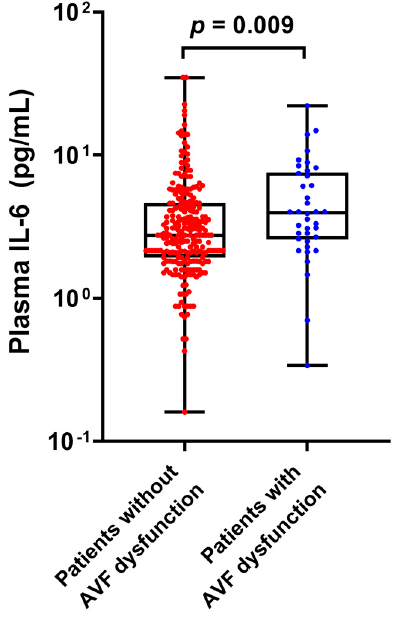
Figure 2. Plasma IL − 6 levels according to the occurrence of AVF dysfunction.